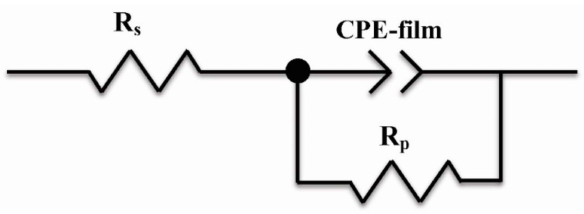
Figure 8. Equivalent circuit used to fit the EIS